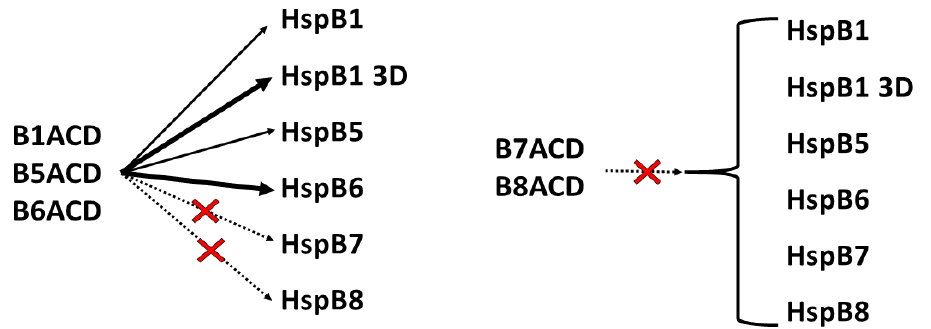
Figure 10. Heterooligomerization scheme of ACDs and full-length sHsps. Thick black lines represent strong interactions, thin black lines represent weak interactions and dashed black lines with red crosses represent a lack of interaction.